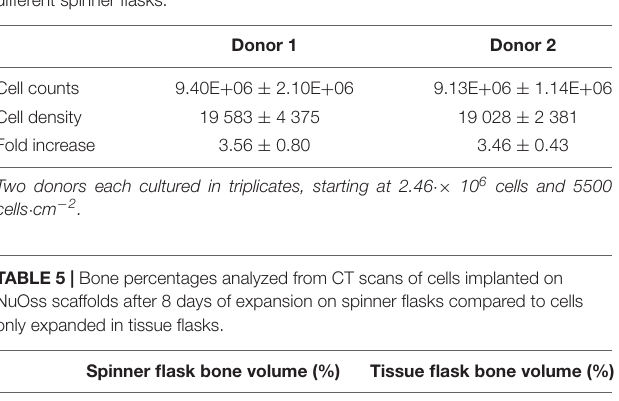
TABLE 4 | Cell quantity after harvesting the cells cultured for 8 days in 6 different spinner flasks.